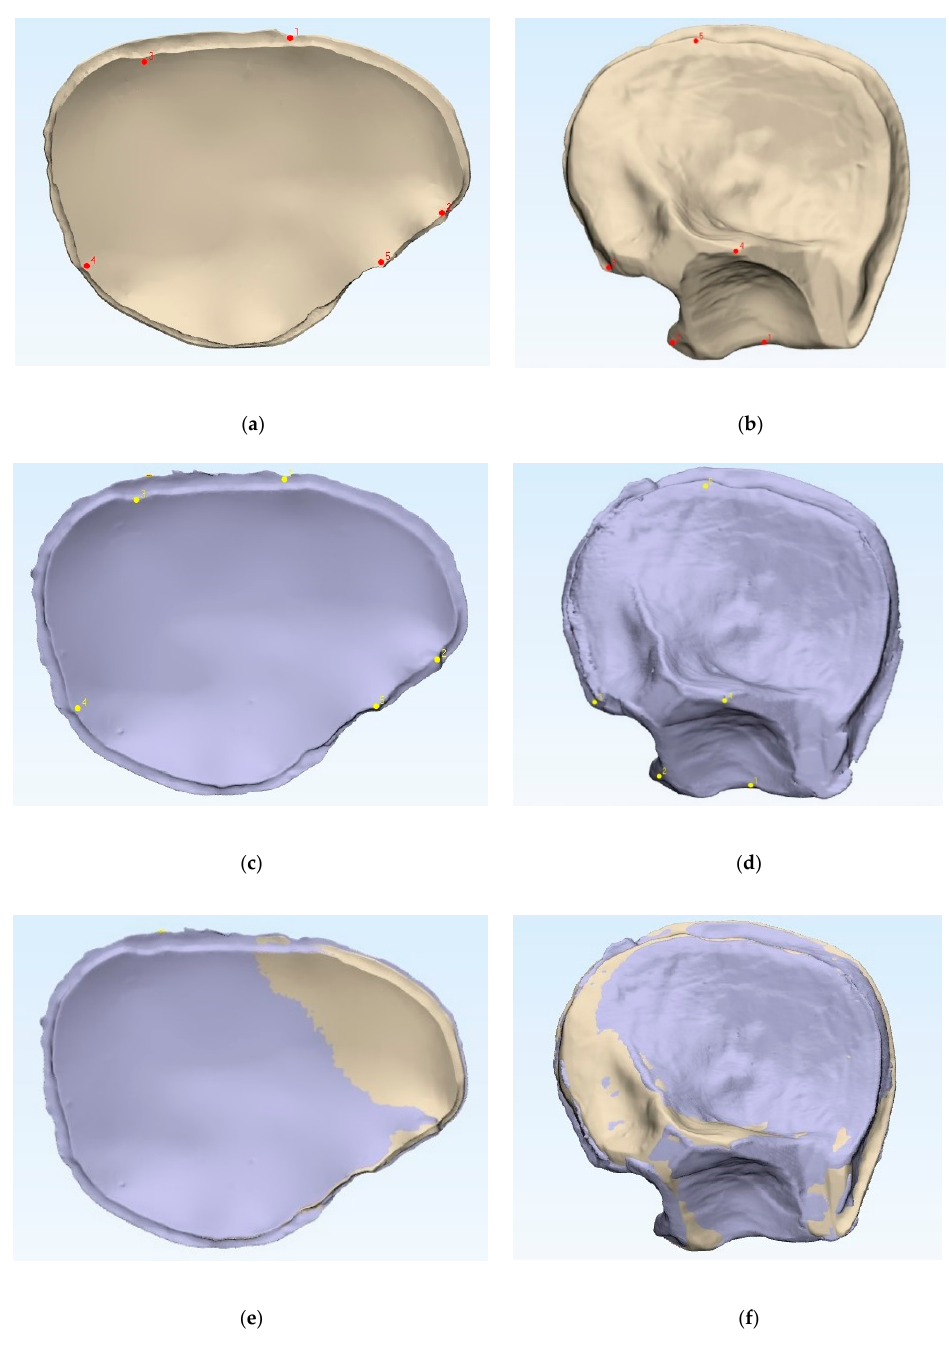
Figure 2. Comparison of the 3D printed templates ( a , b , beige) with the patient-specific implants according to the n-point registration with five manually placed control points ( c , d , purple), and the superimposition ( e , f ). Left: cranial template and PSI; right: temporo-orbital template and PSI.